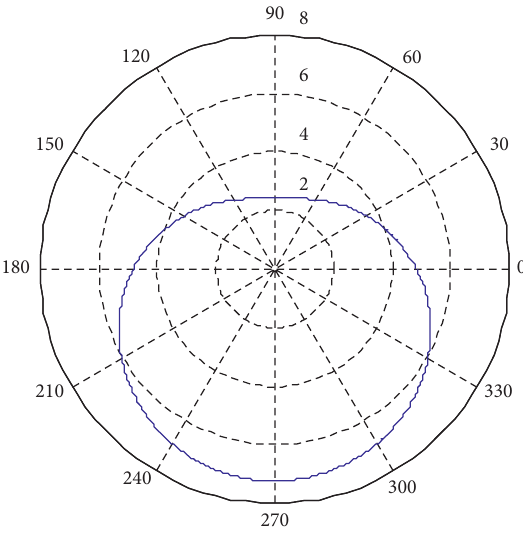
Figure 5: Shape of the